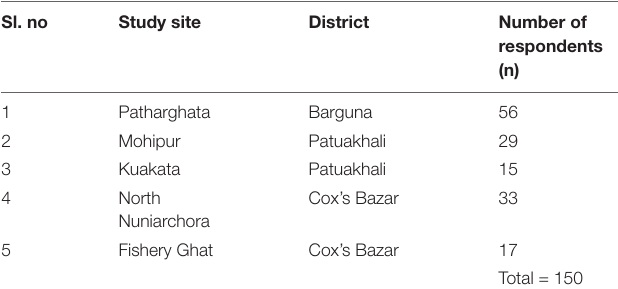
TABLE 1 | Number of respondents surveyed during the fisher survey among the study sites. Sl.